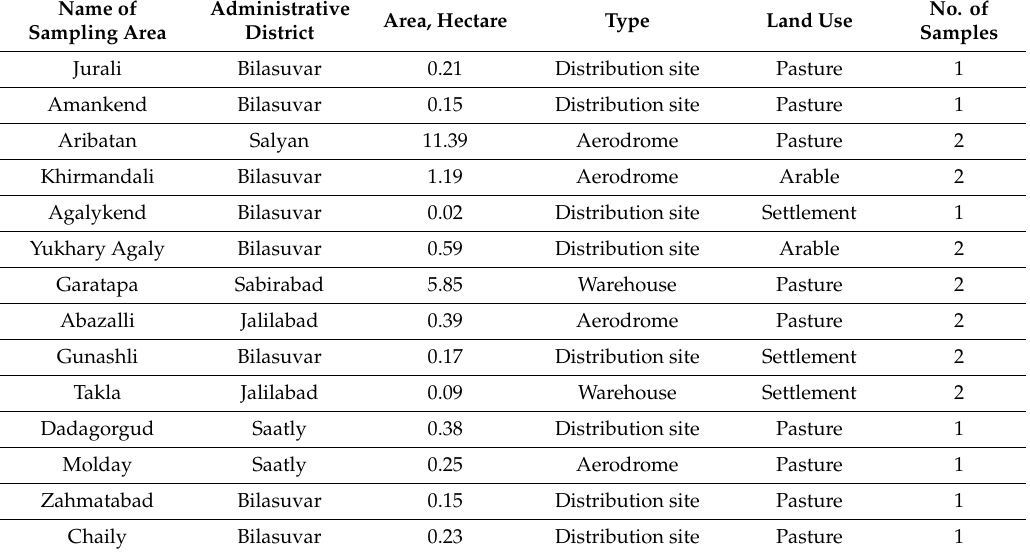
Table 5. Description of the sampling points localization (n =